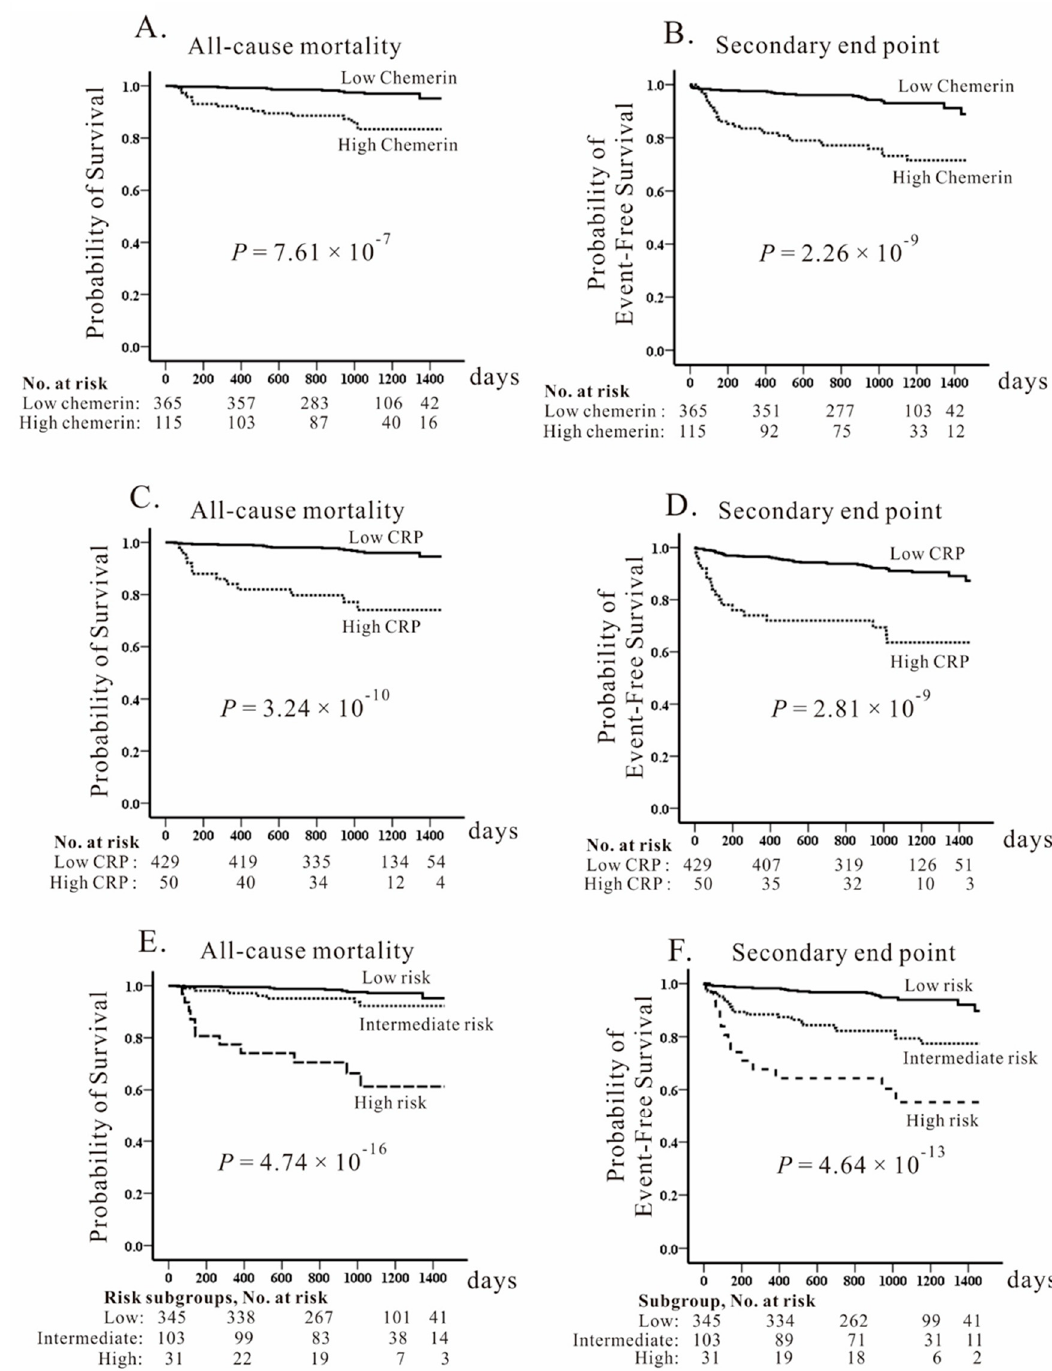
Figure 2. Kaplan–Meier curves of the cumulative incidence of primary and secondary endpoints. Individuals are stratified according to chemerin levels (>163.8 ng/mL vs. ≤ 163.8 ng/mL) ( A , B ) and C-reactive protein (CRP) levels (>9.7 mg/L vs. ≤ 9.7 mg/L) ( C , D ) as well as their combination ( E , F ) in patients with angiographically confirmed coronary artery disease (CAD). Significantly higher mortality and combined endpoints for CAD were noted for higher chemerin and CRP levels as well as higher risk subgroups of combined chemerin/CRP levels. The study patients were followed for 1022 ± 320